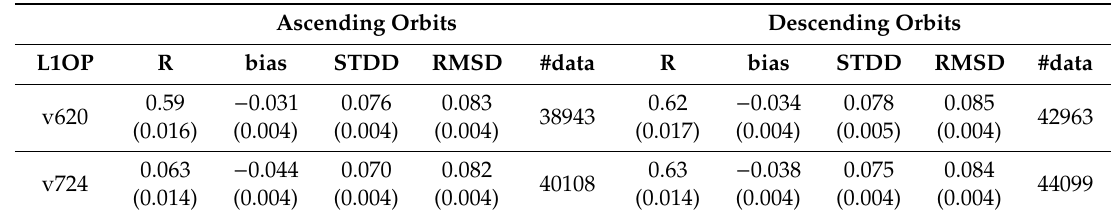
Table 3. ∆ time series statistics and their CI95, 95% confidence intervals, given between parentheses. Ascending Orbits Descending Orbits